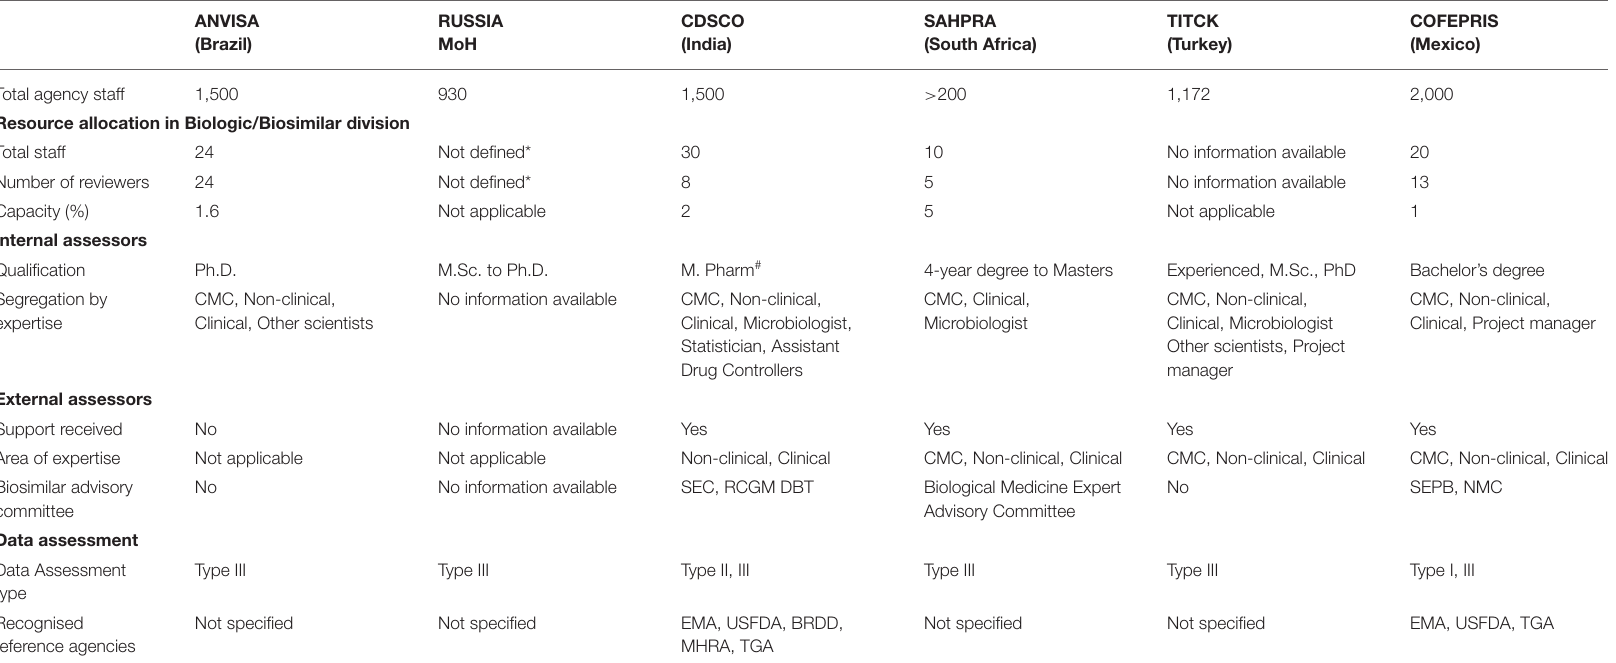
TABLE 2 | Organisation of the six regulatory agencies of the